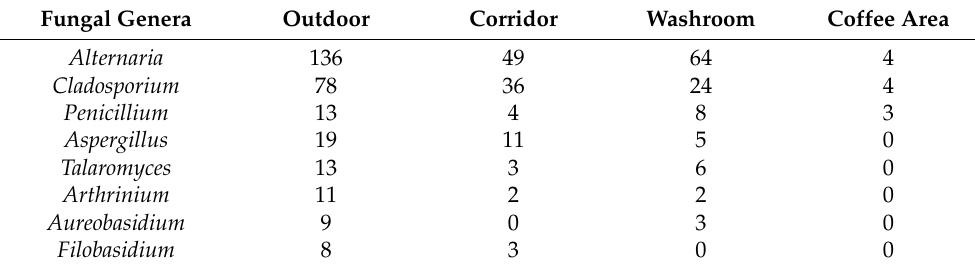
Figure 5. Concentration of airborne fungi in the four sampling environments (CFU/m 3 ). Table 1. The distributions of main fungal genera in 4 sampling environments.